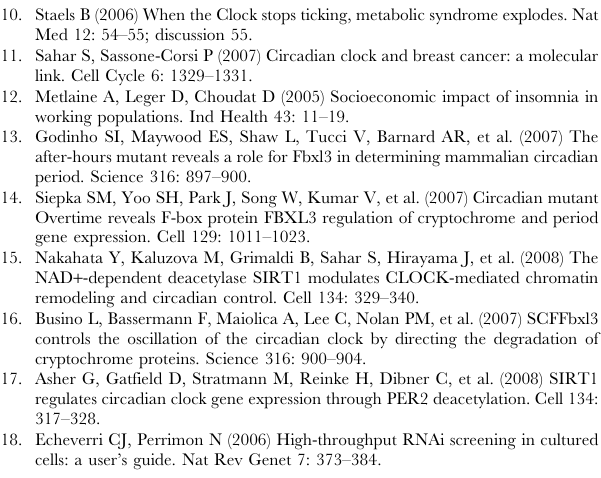
Table S1 siRNA duplex sequences in Excel